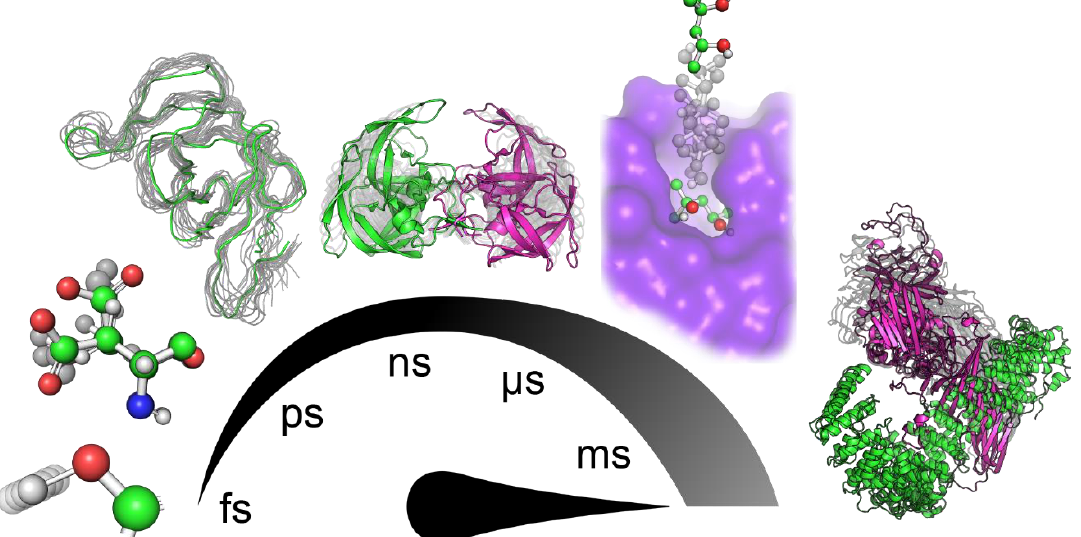
Figure 1. Hierarchy of principal motions in protein dynamics. From left to right: bond vibrations (fs–ps), side-chain rotations (ps–ns), backbone fluctuations (ns), loop motion / gating (ns–ms), ligand binding / unbinding events ( > 100 ns), and collective domain movement ( > µs).